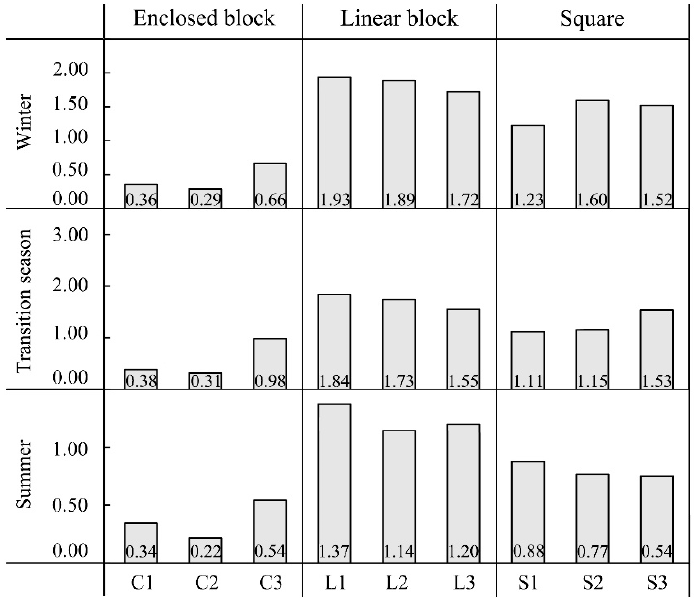
Figure 7. Average wind speed (m/s) of each measurement point in different seasons.